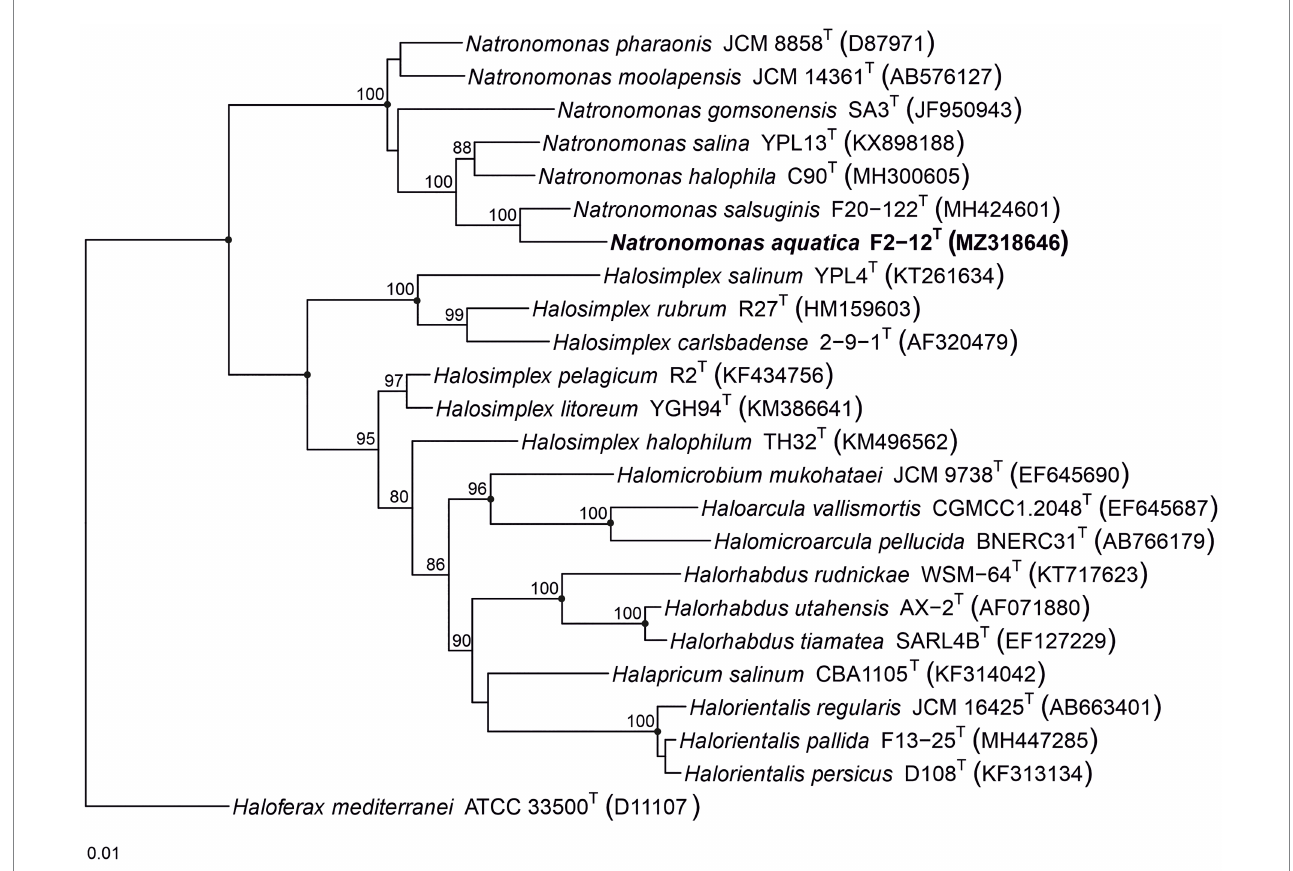
FIGURE 3 Maximum-parsimony phylogenetic tree based on the comparison of the 16S rRNA gene sequences showing the relationship between strain F2-12 T , the species of the genus Natronomonas and other related haloarchaeal genera. The sequence accession numbers are shown in parentheses. Bootstrap values equal or higher than 70% are indicated above the nodes. Black circles indicate that the corresponding nodes were also obtained in the trees generated with the maximum-likelihood and neighbor-joining algorithms. Haloferax mediterranei ATCC 33500 T was used as outgroup. Bar, 0.01 substitutions per nucleotide